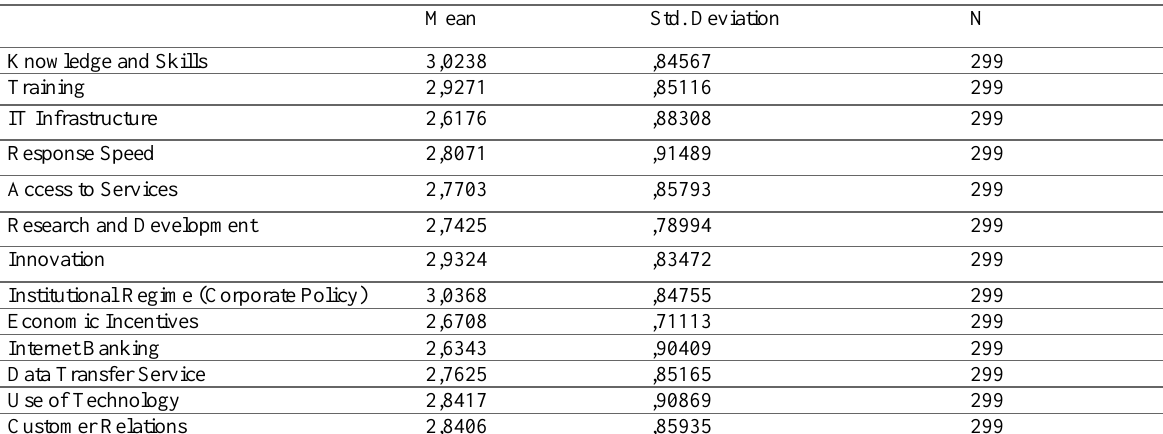
Table 3: Descriptive Statistics of Sub-variables of The Study Mean Std. Deviation